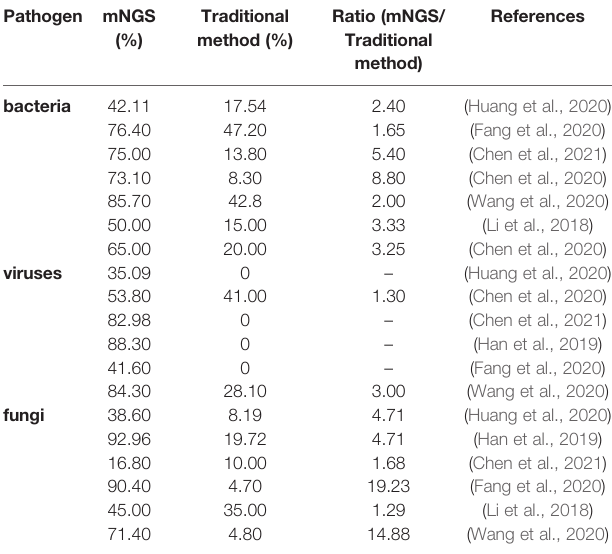
TABLE 1 | Detection rate of pathogens of pulmonary infection in mNGS versus traditional detection methods. Pathogen mNGS